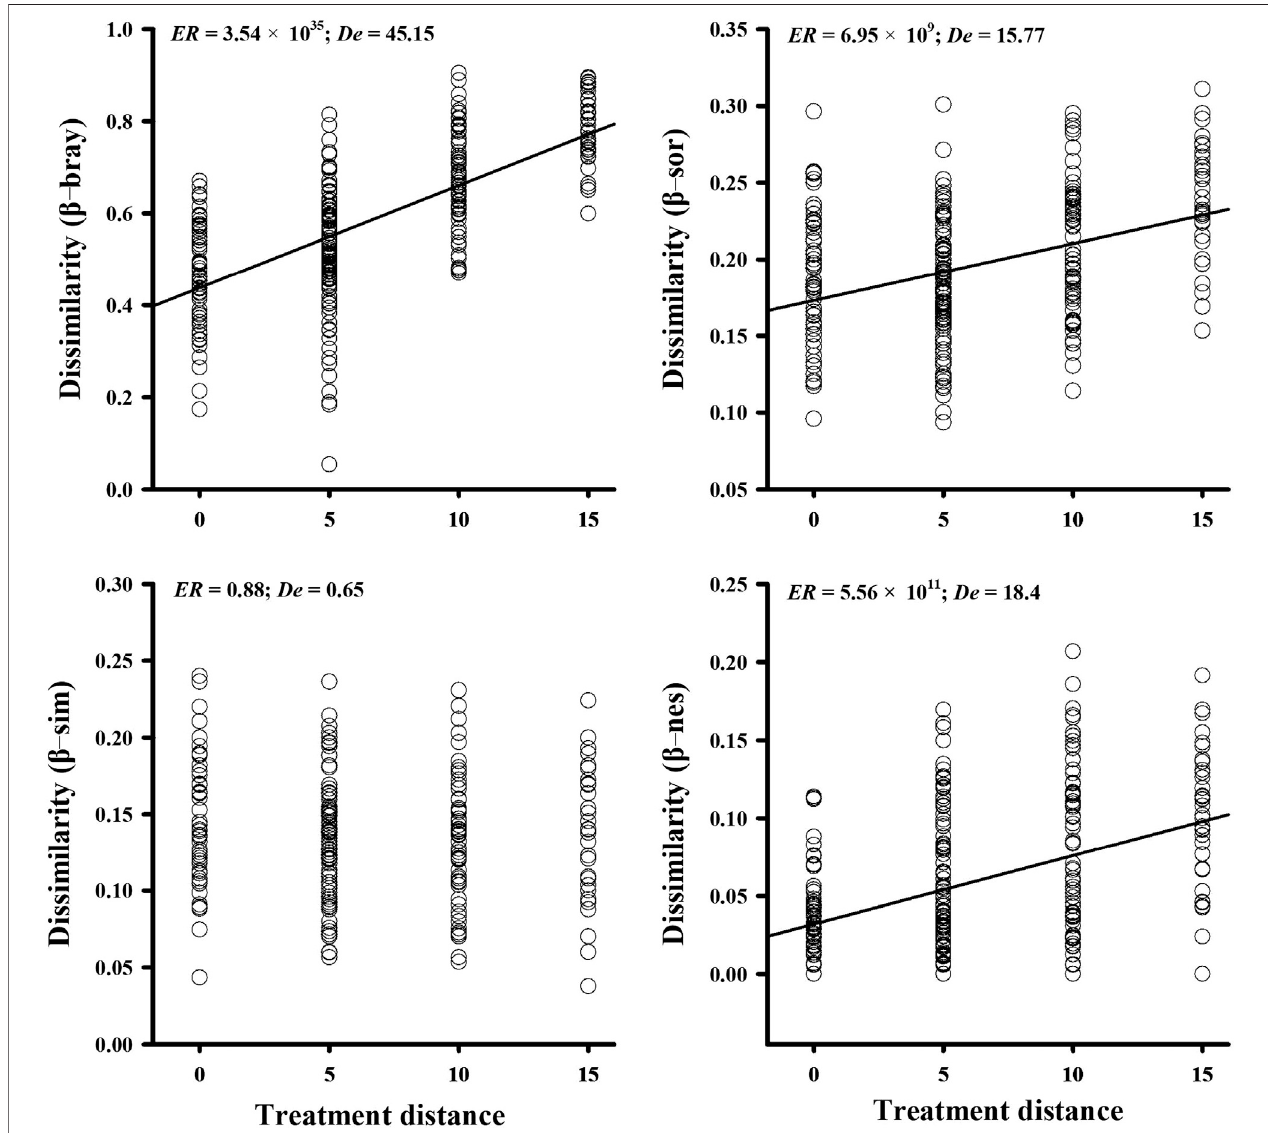
FIGURE 2 | Turnover of the soil AMF community beta diversity of Bray – Curtis ( β -bray; abundance-weighted), Sørensen ( β -sor; presence/absence-based), partitioned Simpson ( β -sim), and nestedness ( β -nes) along the nitrogen addition gradient. ER > 1.5 means a signi fi cant relationship.